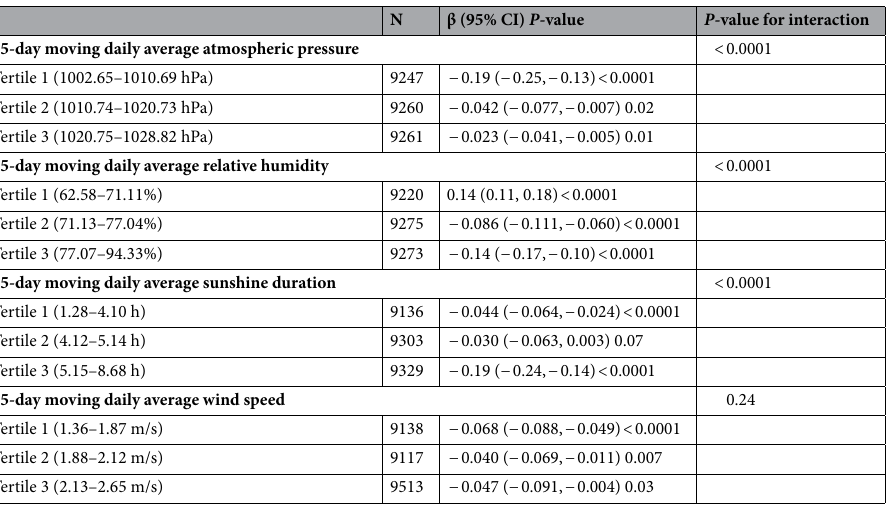
Table 5. Associations between 45-day moving daily average PM 2.5 levels and maternal serum 25OHD levels during second trimester of pregnancy in subgroups stratified by meteorological factors. Adjusted for year, season, 45-day moving daily average atmospheric pressure, sunshine duration, relative humidity and wind speed except the subgroup variable. PM 2.5 particulate matter with an aerodynamic diameter of ≤ 2.5 μm, 25OHD 25-hydroxy vitamin D, CI confidence interval.